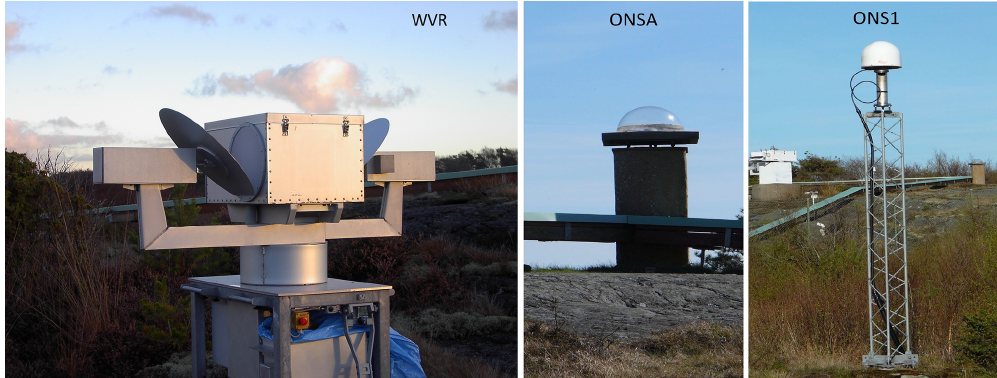
Figure 3. The water vapour radiometer (WVR) and GNSS stations (ONS1 and ONSA) at the Onsala Space Observatory.